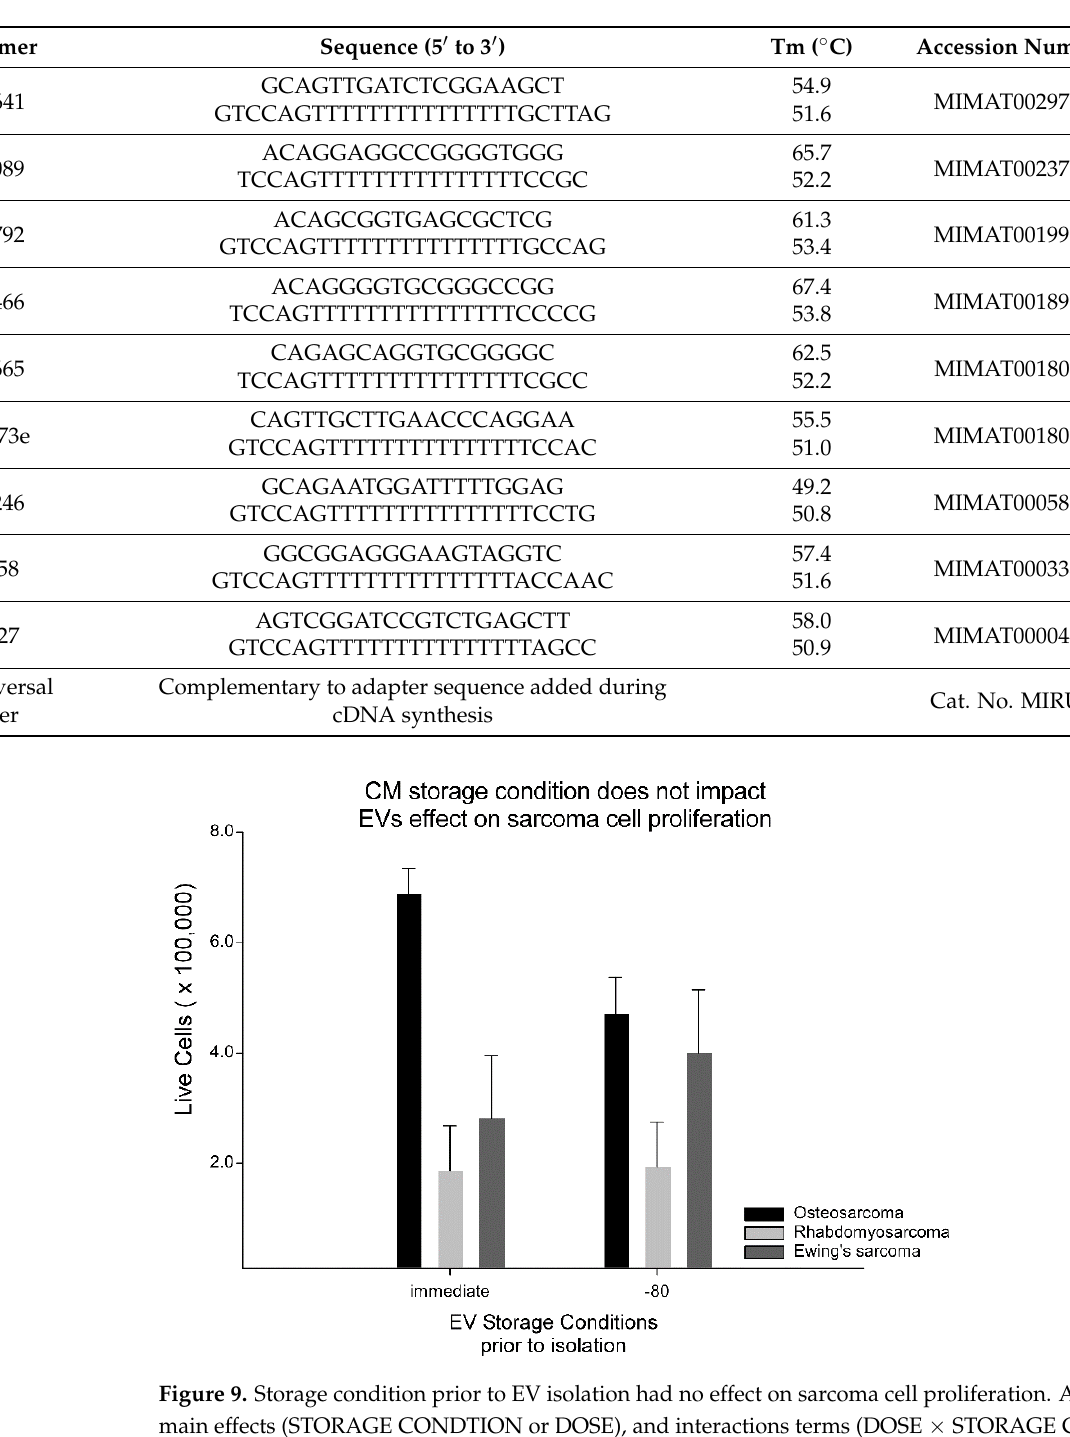
Table 3. RT-PCR Primers.